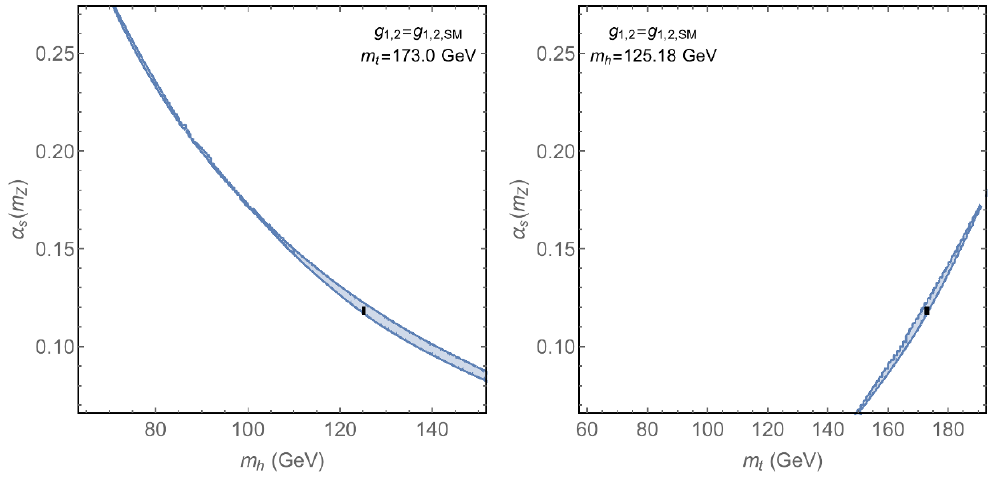
Figure 2 . Correlation of low energy parameters from coupling uni(cid:12)cation with Higgs Parity, projected into the ( m h ; (cid:11) s ) and ( m t ; (cid:11) s )